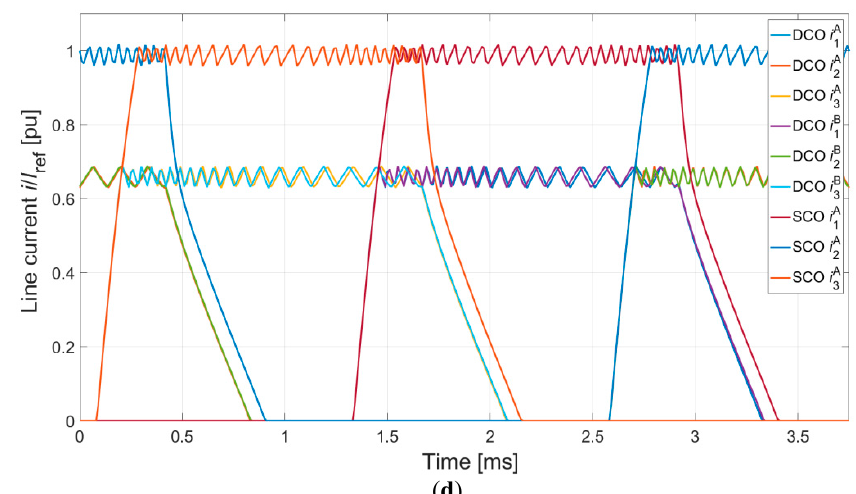
Figure 6. Relative electromagnetic torque and line currents in DCO and SCO for the DCBLDCM and the DCSRM at low speed. (a) Electromagnetic torque T e for a DCBLDCM. (b) Line currents for the DCBLDCM. (c ) Electromagnetic torque for the DCSRM. (d) Line currents for the DCSRM.